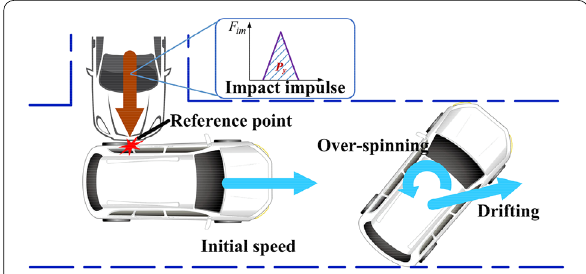
Figure 7 The lateral-rear offset impact